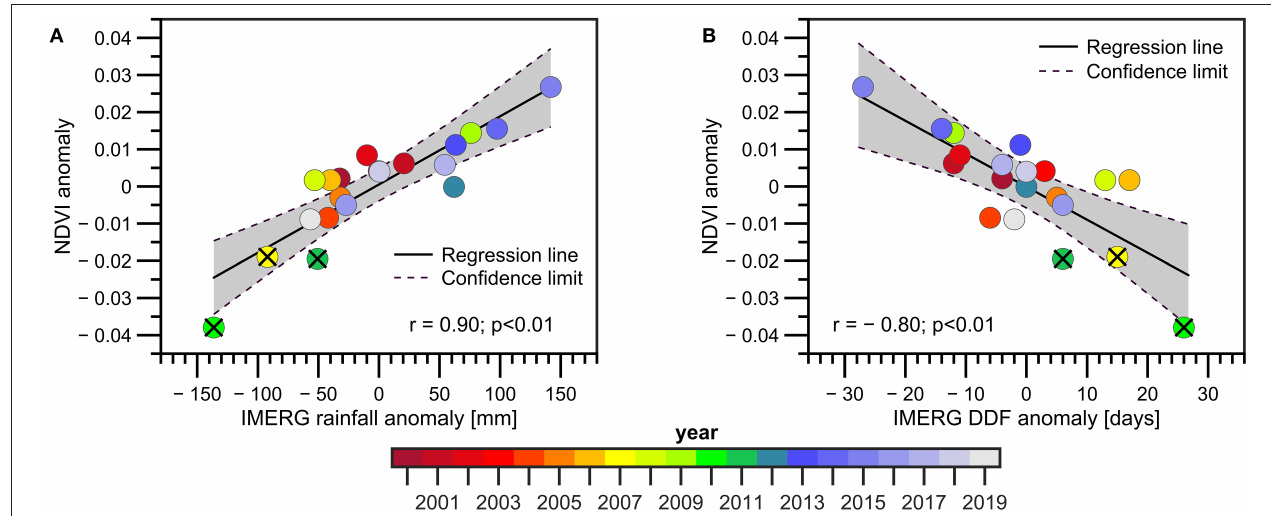
FIGURE 3 | Scatter plots between NDVI anomalies during the Vegetation Dry Season (VDS) for the 2000–2019 period and: (A) precipitation anomalies and (B) the Dry Day Frequency (DDF) during the Precipitation Dry Season (PDS) in the upper Madeira Basin. Precipitation and DDF anomalies are estimated using GPM-IMERG data. NDVI anomalies are calculated below the 1,000 m.a.s.l. The corresponding years, the regression line, the confidence interval (95%), the correlation coefficients and the p -value are indicated in (A,B) . The extreme drought years (2007, 2010, and 2011) are indicated with the X